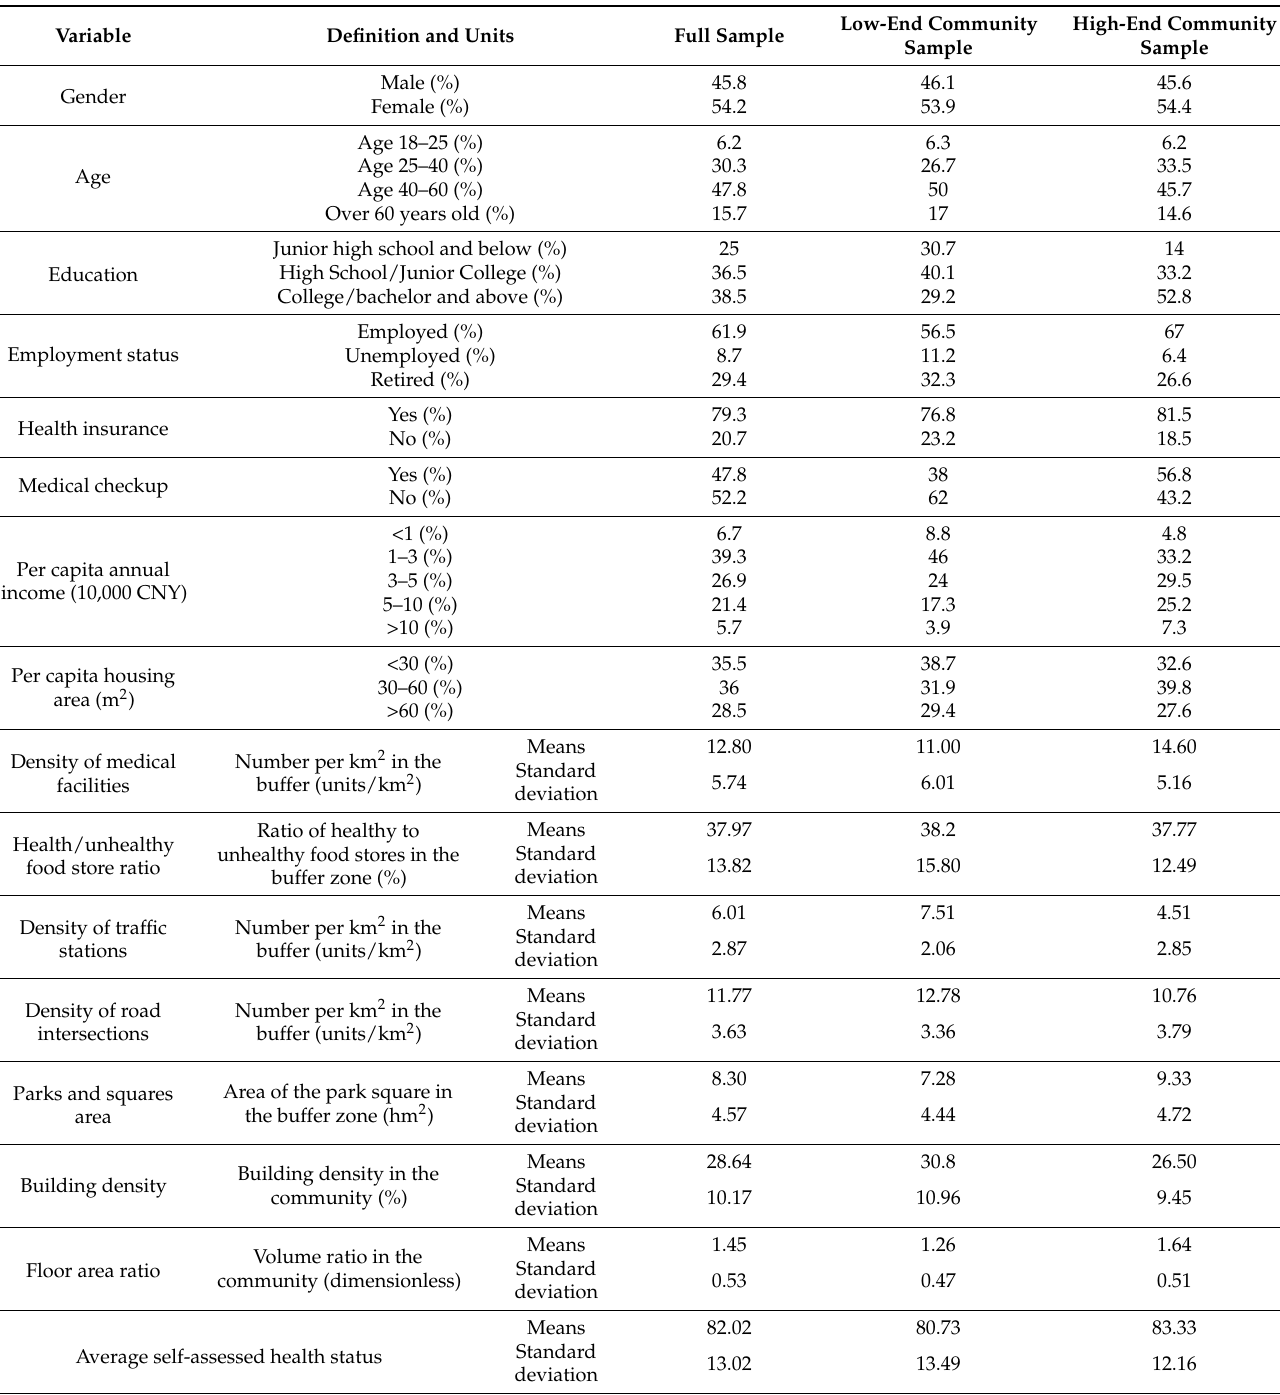
Table 3. Statistical Description of the Individual Attributes of the Surveyed Residents and the Attributes of the